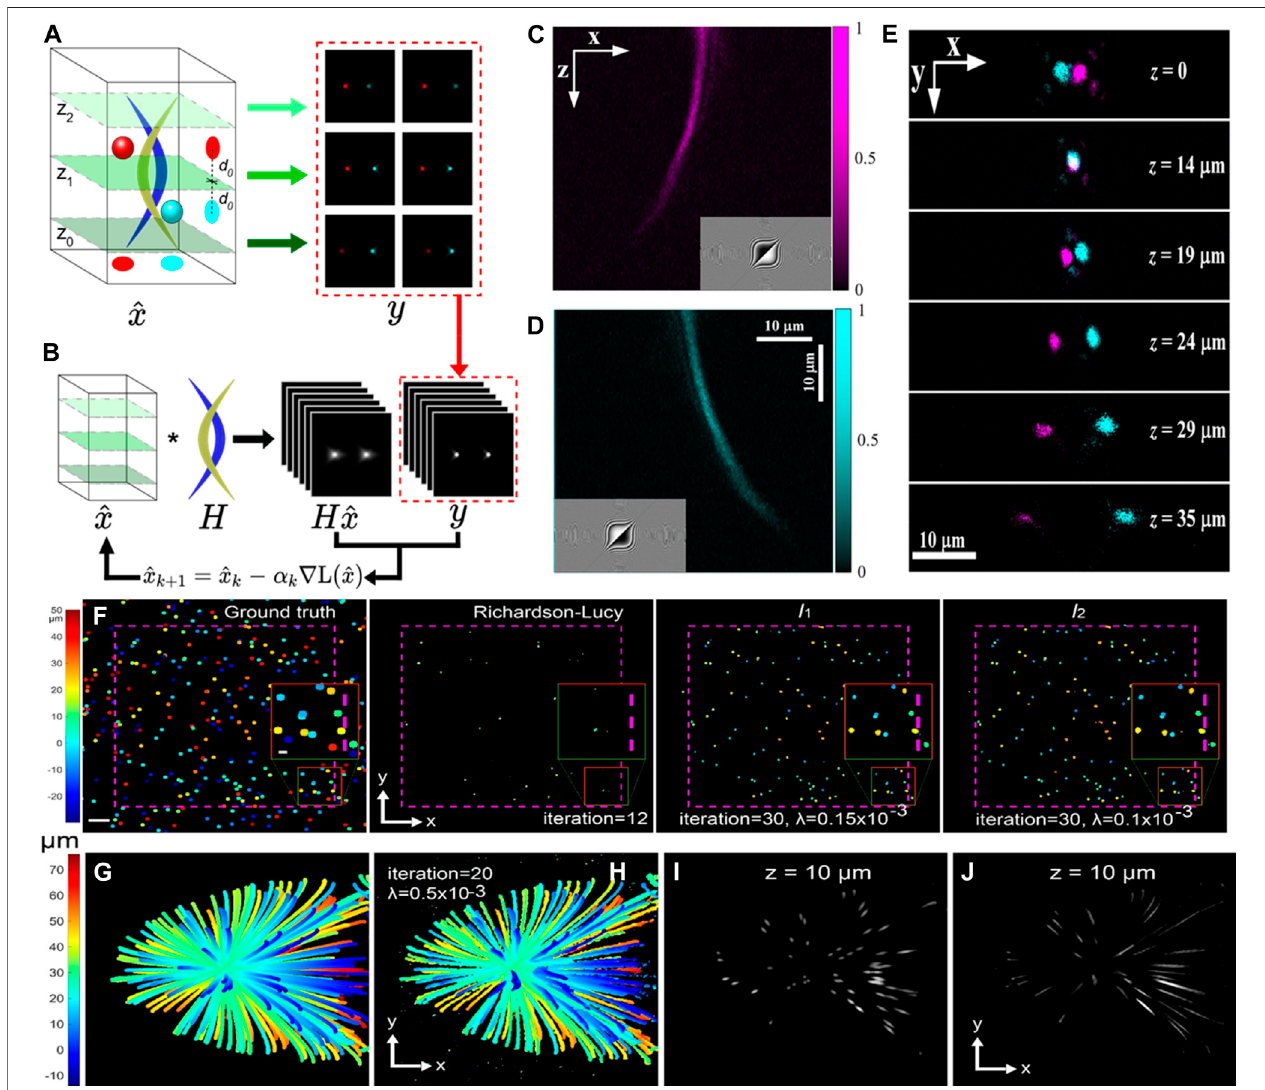
FIGURE 14| (A) Images are collected at multiple planes in sequence using Airy beams with reversed bending. Although the magnitudes of lateral shifts for the two spheres are nearly identical for images taken at z 1 , they become distinguishable after shifting the focal plane. (B) Images created by the convolution of the retrieved volume and PSFs. The gradient descent is applied to minimize the loss function [152]. Two-photon intensity pro fi le for a fl uorescence microsphere with (C) left (red) and (D) right(green)Airybeams.InsetsshowtherespectiveCPMdisplayedonSLM. (E) Synthesizedcolorimageof fl uorescencemicrosphereexcitedwithleftandright Airy beams along z-axis [87]. (F – J) Maximum intensity projection (MIP) reconstructedfrom image sequence withaverageSNR of3.32 dB and peak SNRof 23.88 dB at six axial locations. (F) Depth color-coded MIPs toward the z - direction for the ground truth, reconstructions with Richardson – Lucy deconvolution, ℓ 1 - and ℓ 2 -GD. Magentaboxshowsascanningareaof512 × 512pixels.Scalebars,5 μ m. (G – J) MIPofasimulatedmicrotubulenetworktowardthe z -directionwithcolor-codeddepth for (G) the ground truth and (H) the optimization. An image section at z (cid:2) 10 μ m of (I) the ground truth and (J) the optimization. Reproduced with permission from OSA [87,